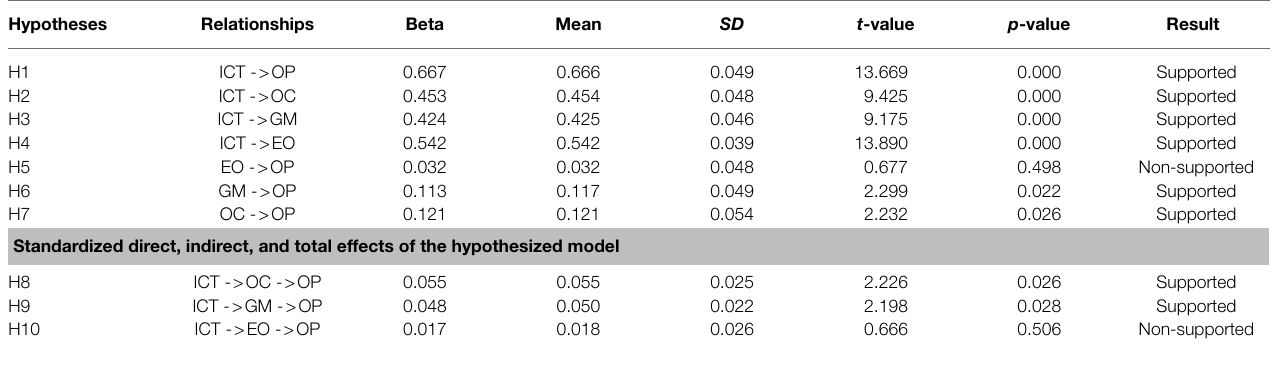
TABLE 3 | Path coefficients and hypothesis